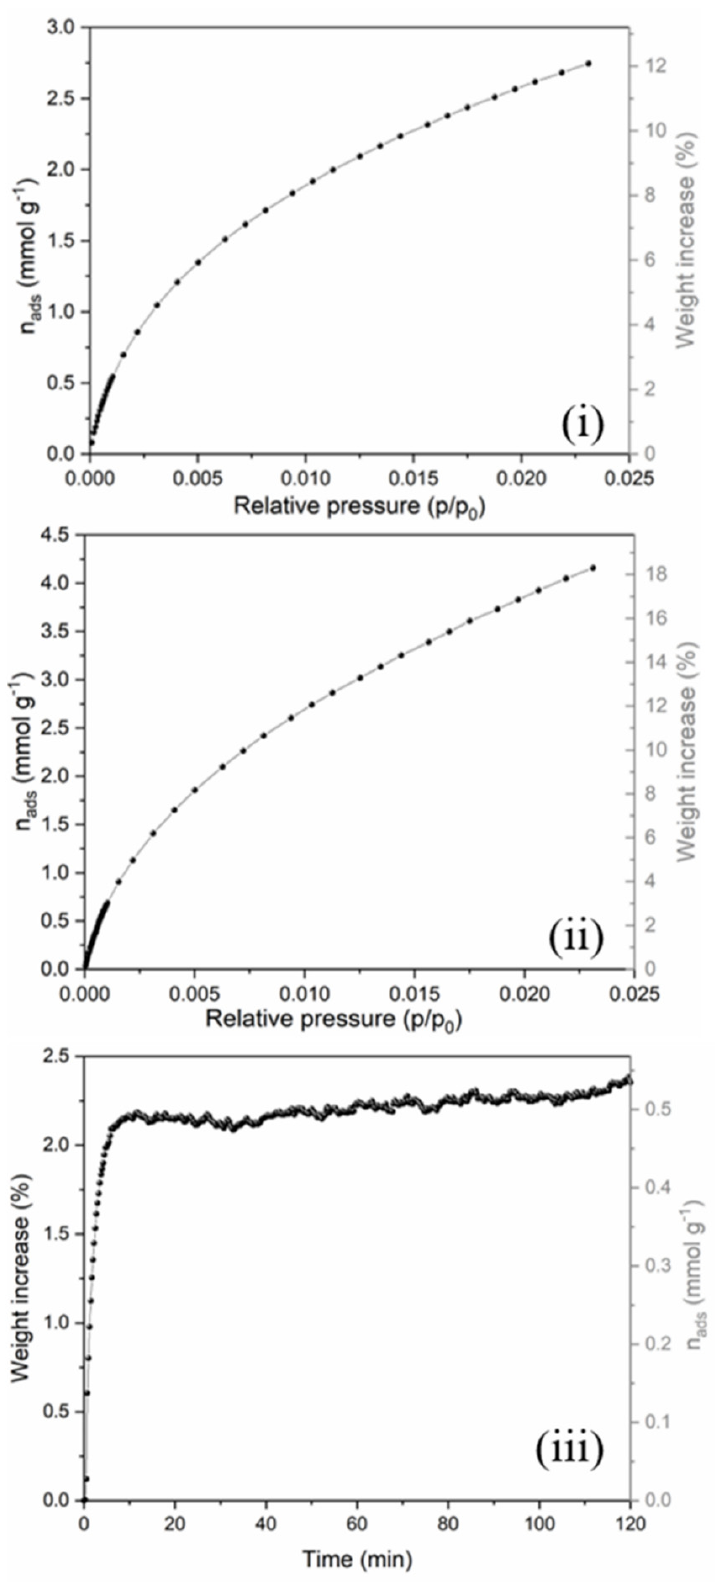
Figure 7. CO 2 adsorption isotherms of ( i ) CNF_230 and ( ii ) CNF_260 at 20 ◦ C in pure CO 2 atmosphere and ( iii ) CO 2 /N 2 selectivity test of CNF_230 mat at 30 ◦ C in a simulated post-combustion flue gas mixture of 20 vol.% CO 2 and 80 vol.% of N 2 .